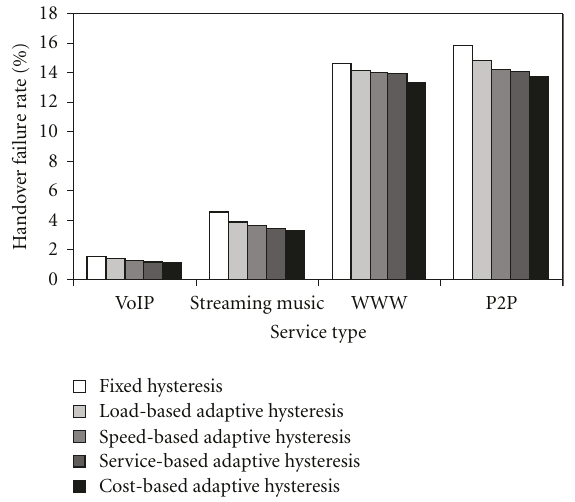
Figure 6: HFR per service type by the five hysteresis schemes when call arrival rate is fixed at 0.03.